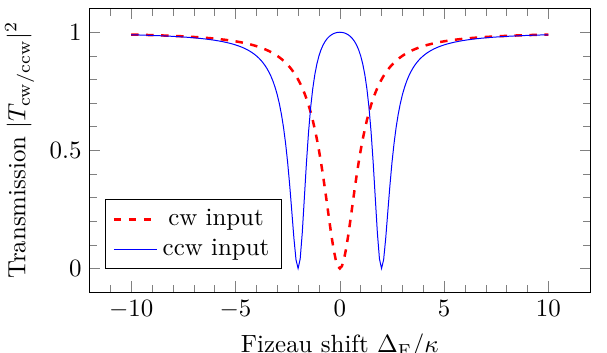
2 of the optical input field versus the T cw,ccw | |